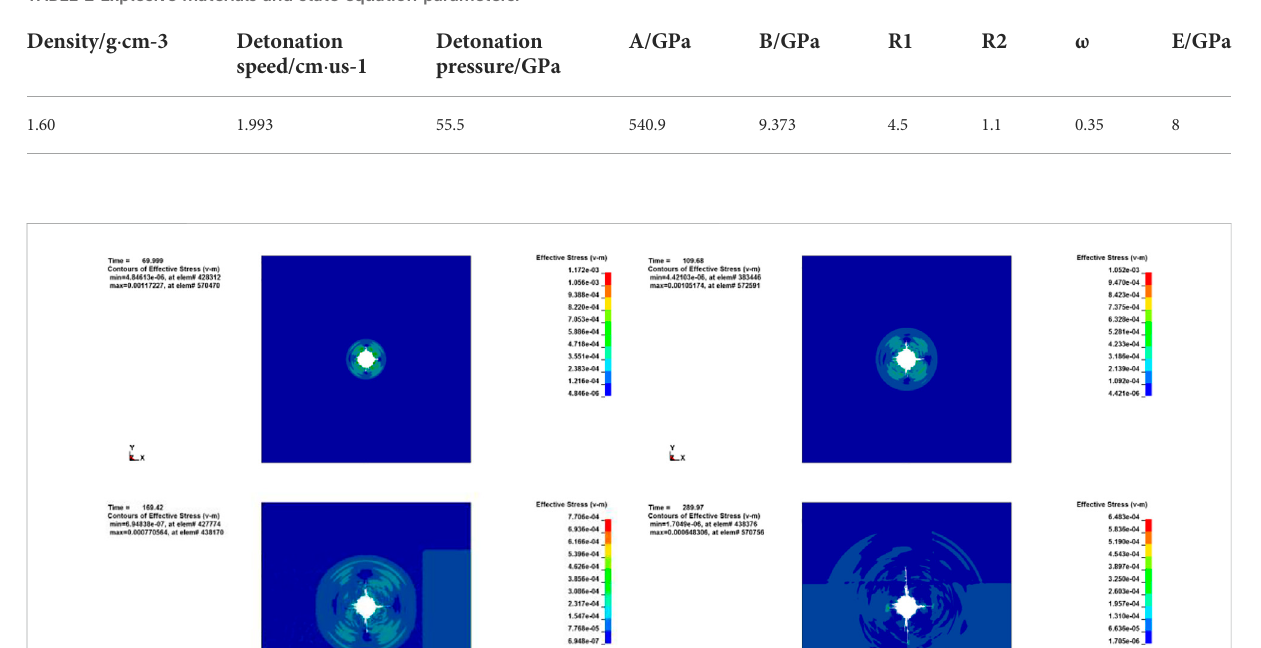
TABLE 2 Explosive materials and state equation parameters.